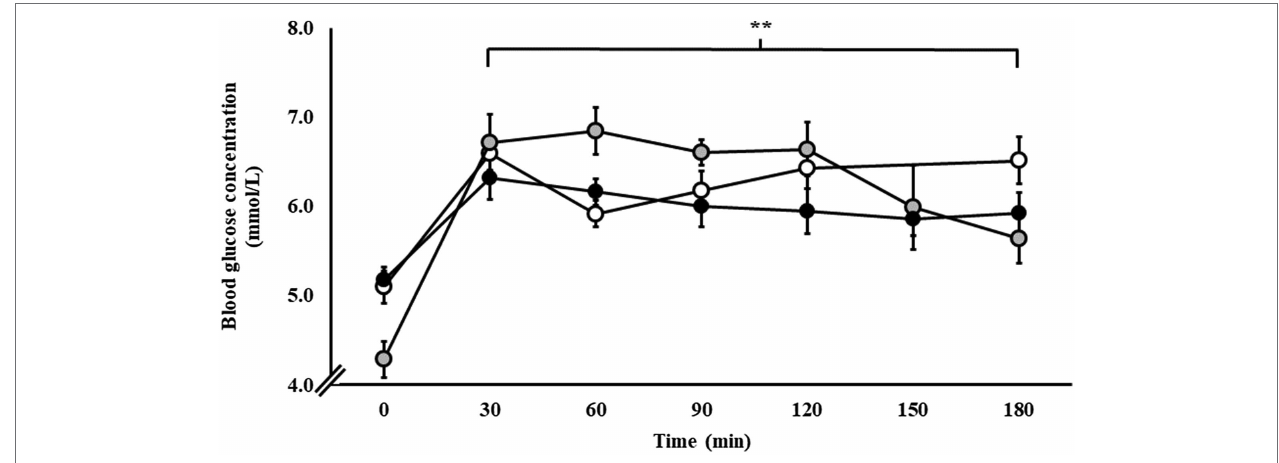
FIGURE 2 | Blood glucose responses during steady-state running with CHO provision on P1 ( ○ ), P2 ( ● ), and P3 ( ● ). Mean ± SEM ( n = 28): ** p < 0.01 vs. 0 min. P1: formulated gel-disc containing 30 g CHO with 300 ml water (10% w/v , 90 g/h, 2:1 glucose–fructose, 316 mOsmol/kg), at 0 min and every 20 min thereafter for 120 min; followed by water provisions ad libitum for the 3rd h (270 ± 215 ml). P2: CHO beverage containing 25 ± 3 g CHO (10% w/v , 76 ± 8 g/h, 509 mOsmol/kg; equivalent to 1.0 g/kgBM/h) at 0 min and every 20 min thereafter for 120 min, then water provisions ad libitum for the 3rd h (170 ± 122 ml). P3: CHO beverage containing 45 g CHO (16% w/v , 90 g/h, 2:1 glucose–fructose, 460 mOsmol/kg), at 0 min and every 30 min thereafter for 180 min. Water provisioned ad libitum , but not consumed by participants (0 ± 0